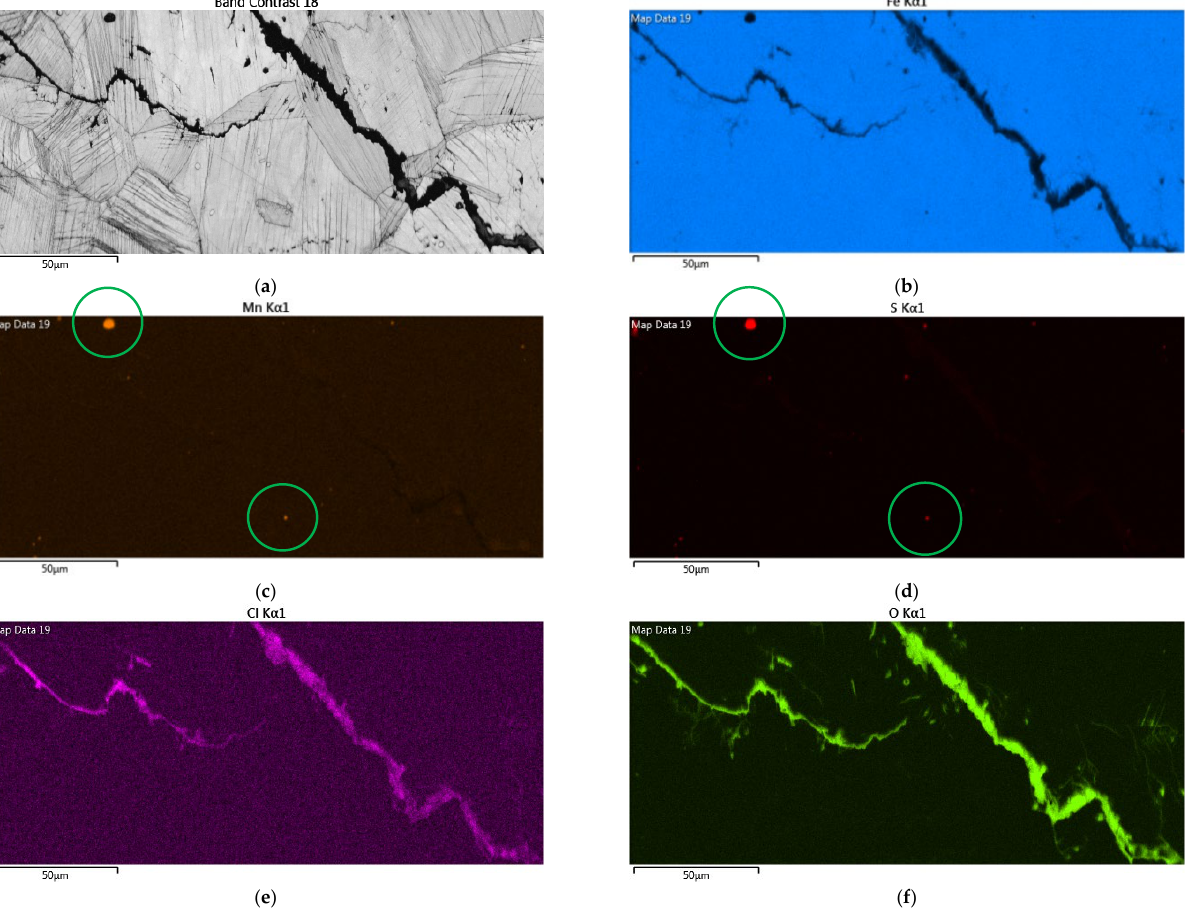
Figure 12. EDS mapping for the crack regions of those samples with a chloride concentration of 1 g/m 2 tested for 7000 h at a relative humidity of 70%: ( a ) Band contrast image, ( b ) Fe mapping, ( c ) Mn mapping, ( d ) S mapping, ( e ) Cl mapping, and ( f ) O mapping.